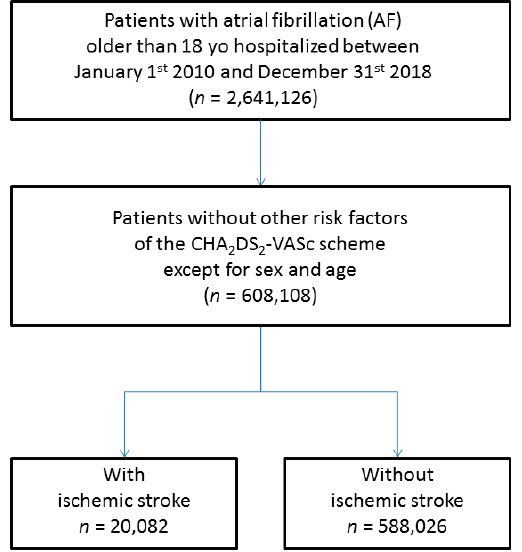
Figure 1. Flowchart of the study population. CHA 2 DS 2 -VASc score: (congestive heart failure, hypertension, age ≥ 75 years (doubled), diabetes, stroke/transient ischemic attack/thromboembolism (doubled), vascular disease (prior myocardial infarction, peripheral artery disease, or aortic plaque), age 65–75 years, sex category (female)).